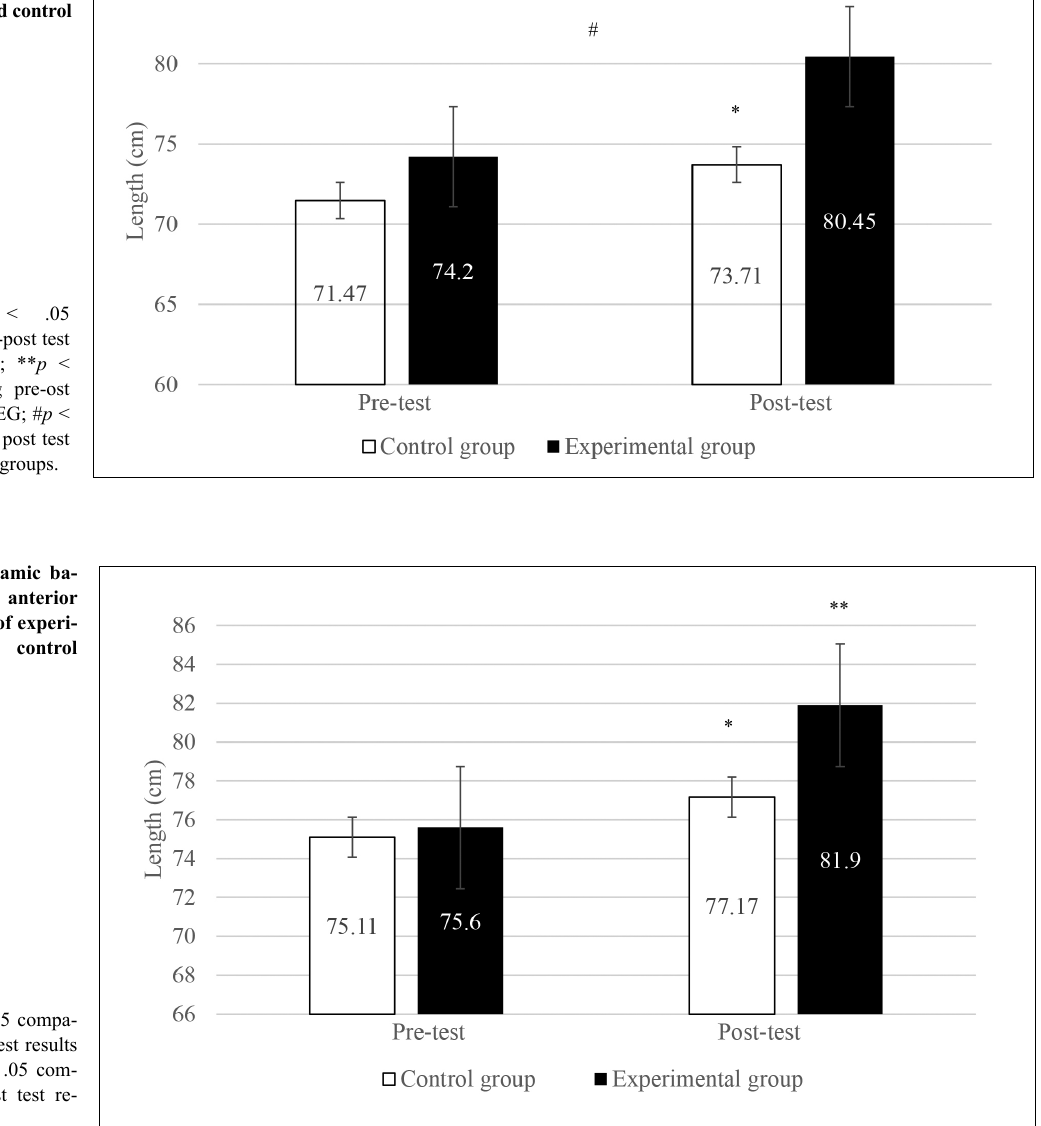
(right posterolateral and right posteromedial reach) results of both groups: EG and CG (Figure 8). Left posteromedial and left posterolateral reach results . Pre-test left posteromedial reach result of EG reached 77.85 ± 2.23 cm,